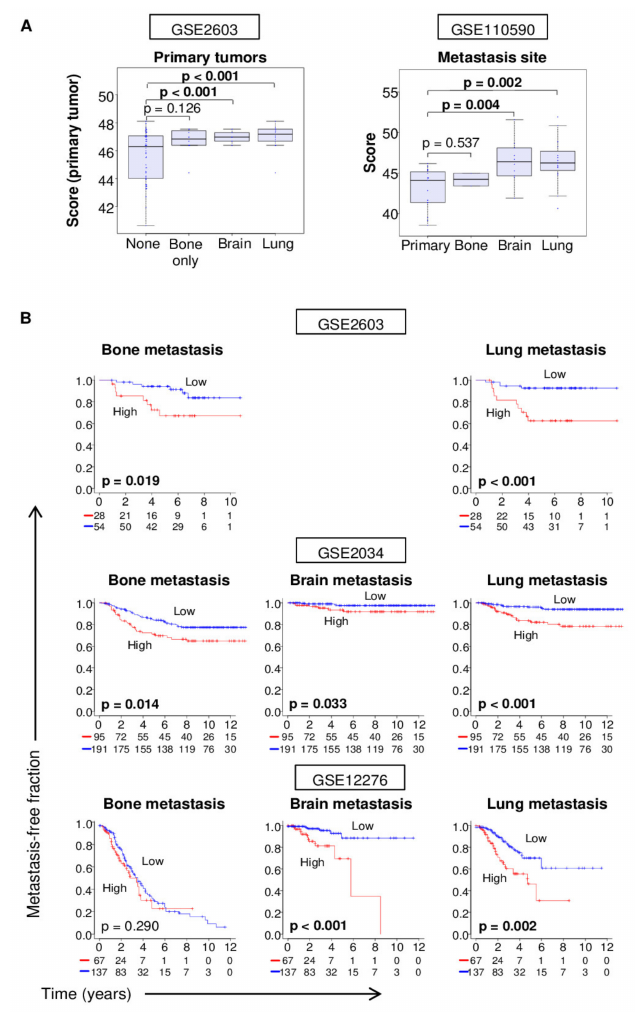
Figure 4. Association of the 4-gene score with metastasis in breast cancer. The examined cohorts are indicated. ( A ) Boxplots show 4-gene scores of primary tumors and metastases of patients who later developed metastasis to only bone, or to sites that included brain or lung, or did not have any metastasis. All boxplots are of Tukey type and the boxes depict medians and inter-quartile ranges. The depicted p values were calculated with standard t tests. ( B ) The Kaplan–Meier survival plots depict metastasis-free survival for metastasis to bone, brain, or lung based on the pre-metastasis primary tumor’s 4-gene score for three cohorts. For each plot, within-cohort one-third percentile value of the score was used to classify tumors into low and high